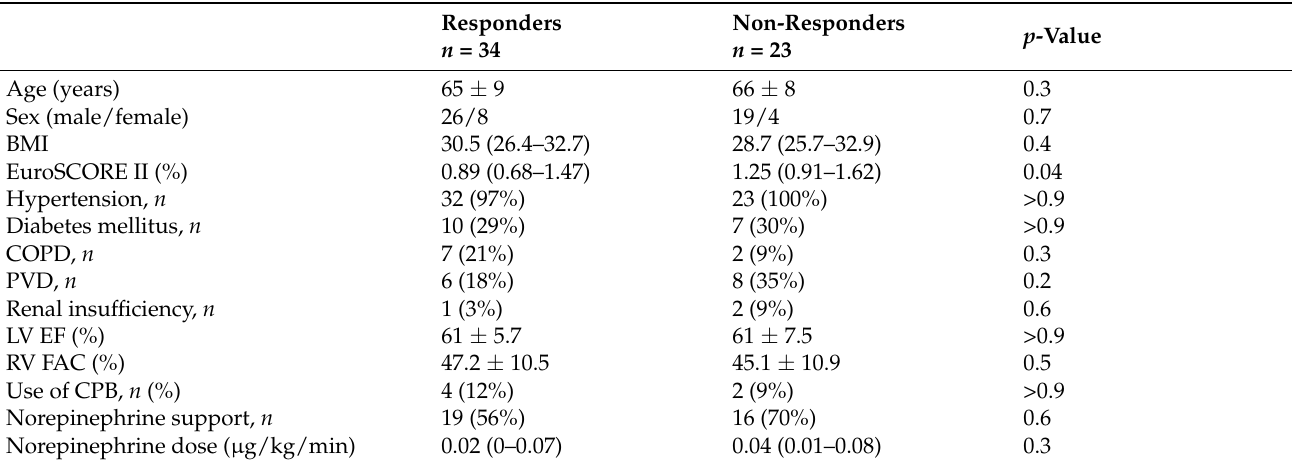
Figure 1. Flowchart of patient inclusion. Table 1. Characteristics of the study population.